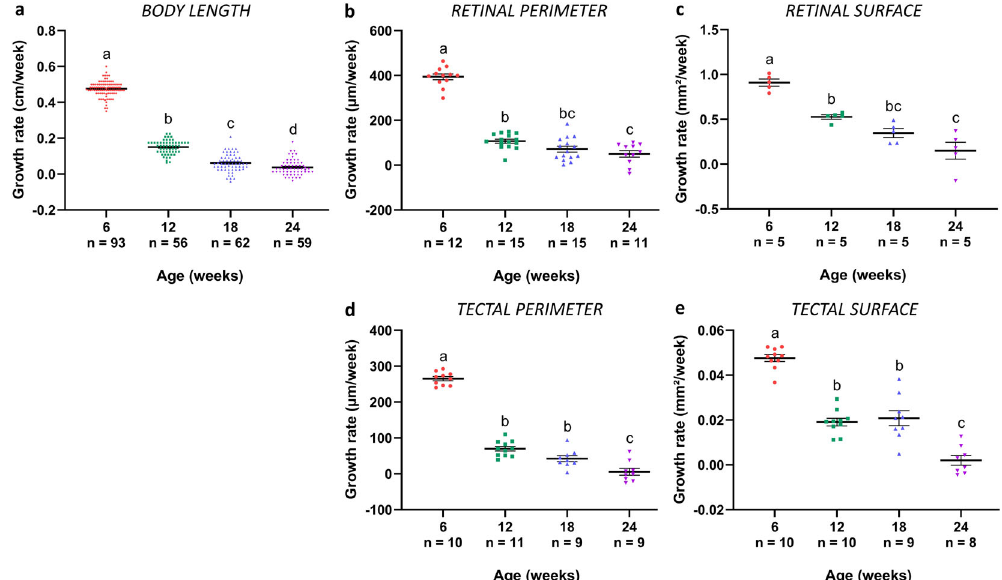
Fig. 1 Changes in growth rate in the GRZ-AD Nothobranchius furzeri . a Growth rate of body length in 6-week-, 12-week-, 18-week-, and 24- week-old fi sh signi fi cantly decreases in all age groups. n ≥ 56. b Growth rate of the retinal perimeter, analyzed on mid-sagittal cryosections, signi fi cantly declines between 6 weeks and 12 weeks. Thereafter, growth rate does not reduce any further. n ≥ 11. c Also the growth rate of the retinal surface, determined on wholemounts, shows a signi fi cant decrease between the age of 6 weeks and 12 weeks. n = 5. d Growth rate of the tectal perimeter, analyzed on coronal cryosections of the central optic tectum, declines upon aging, with a signi fi cant reduction between the age of 6 weeks and 12 weeks, and between 18 weeks and 24 weeks. n ≥ 9. e Similar to the tectal perimeter, assessing growth rate of the tectal surface demonstrates a signi fi cant drop in growth rate between 6 weeks and 12 weeks, and 18 weeks and 24 weeks of age. n ≥ 8. All data are depicted as mean ± standard error of mean, statistical signi fi cance between different age groups is indicated using different